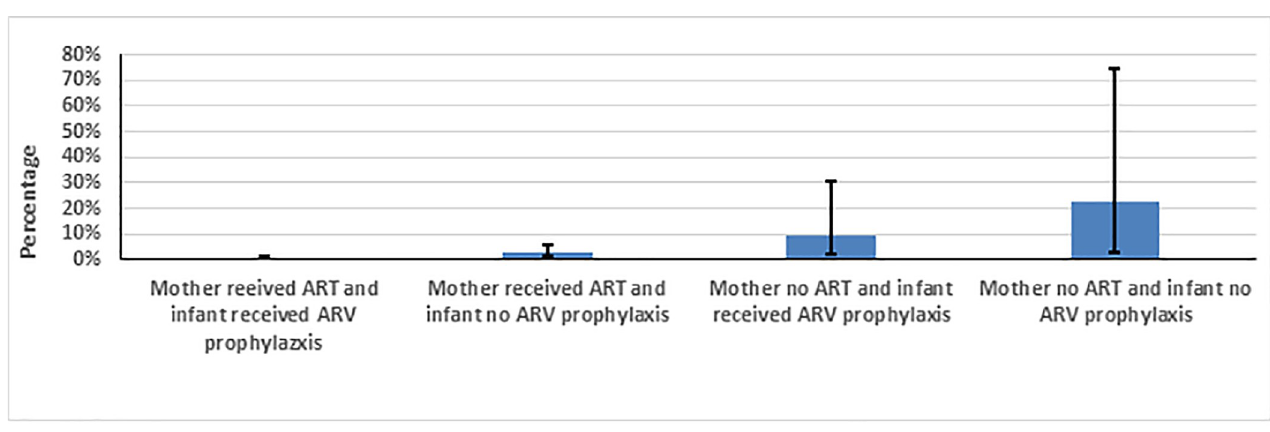
Fig 3. Weighted early MTCT prevalence measured at 4–12 weeks post-partum by maternal ART and infant ARV prophylaxis, Namibia,